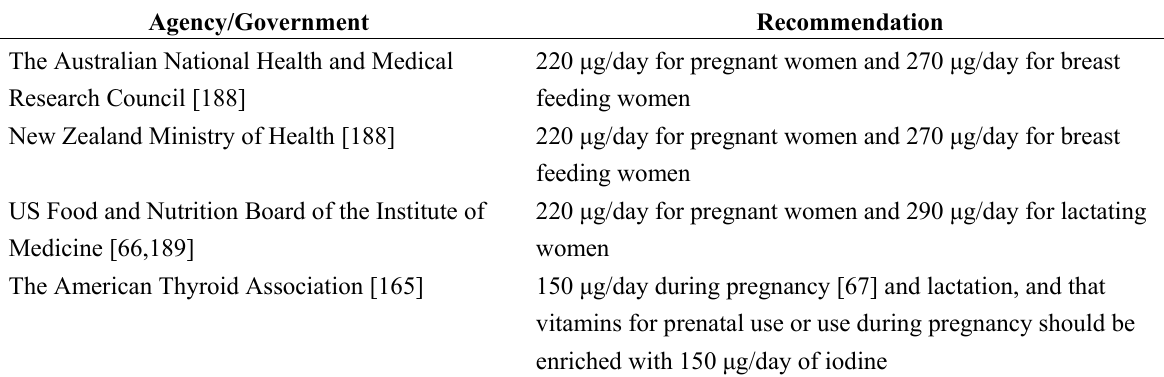
Table 3. Recommended Iodine